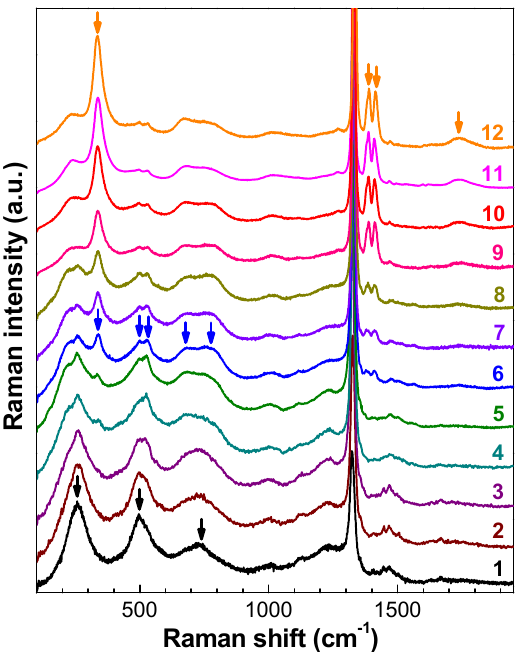
Figure 4. Transformation of the Raman spectra of neutron-irradiated diamond with a fluence of 2 × 10 20 cm − 2 , depending on the annealing temperature. The annealing temperatures for the spectra were (1) 1080 ◦ C, (2) 1150 ◦ C, (3) 1250 ◦ C, (4) 1300 ◦ C, (5) 1375 ◦ C, (6) 1465 ◦ C, (7) 1505 ◦ C, (8) 1535 ◦ C, (9) 1610 ◦ C, (10) 1650 ◦ C, (11) 1665 ◦ C, and (12) 1680 ◦ C. The spectra were vertically shifted for clarity. The arrows indicate three groups of bands whose relative intensities synchronously change under annealing.